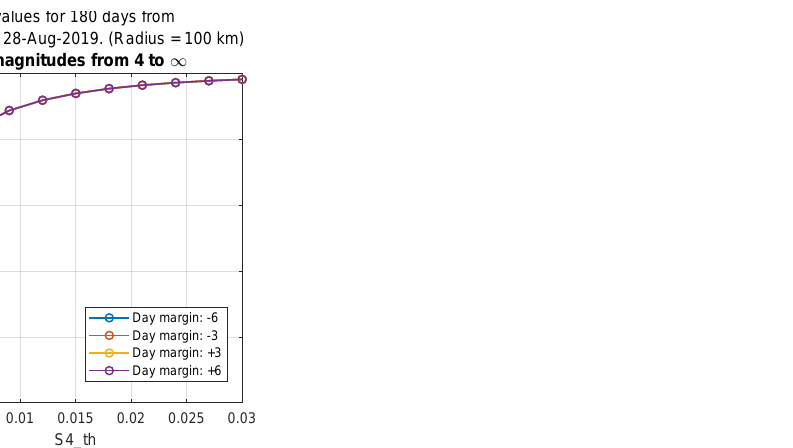
Figure 17. ACC values for two magnitude intervals using radius = 100 km with respect to the ∆ S 4 threshold: s 4_ th